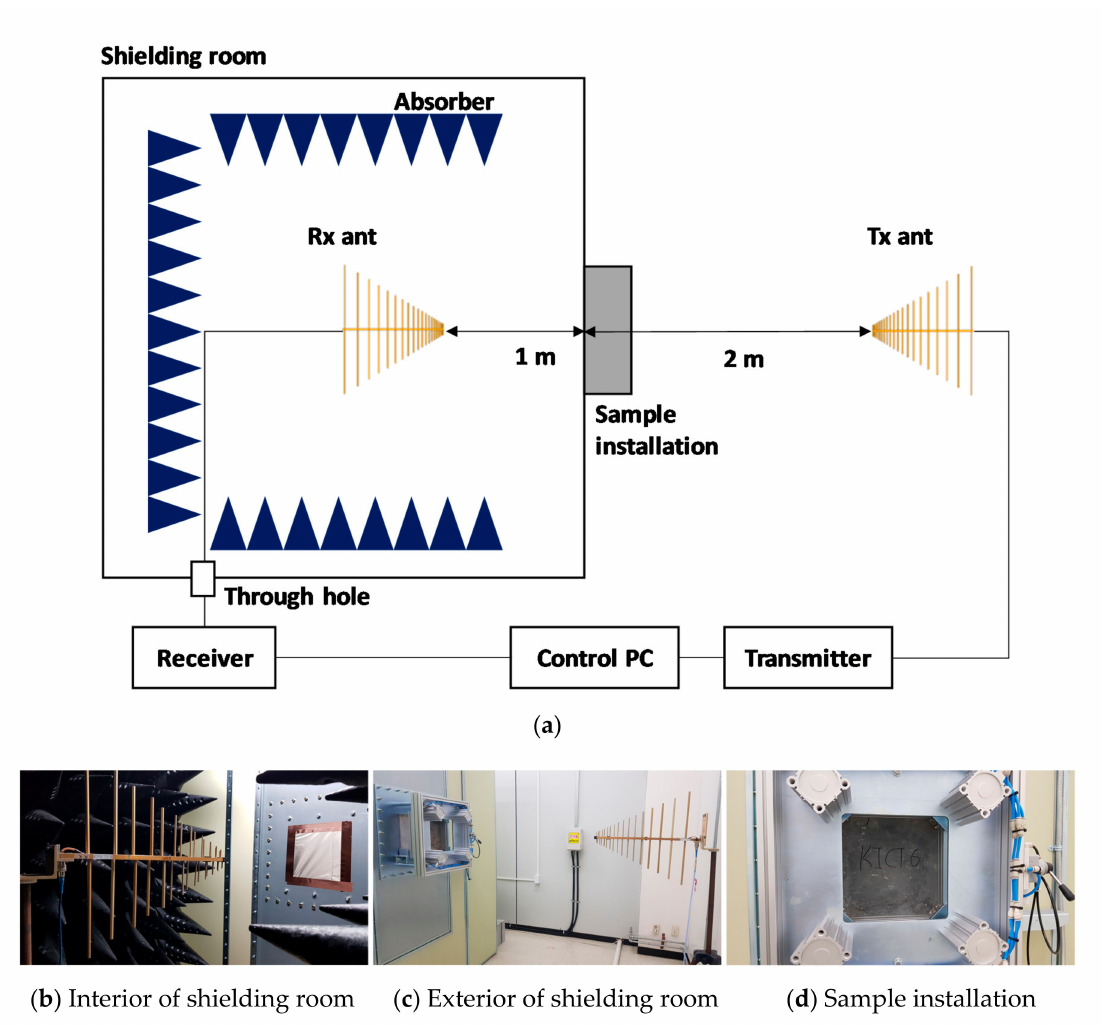
Figure 1. Schematic of the shielding e ff ectiveness (SE) measurement system. ( a ) System configuration, ( b ) Receiving (Rx) antenna placed inside the shielding room, ( c ) Transmitting (Tx) antenna placed outside the shielding room, and ( d ) Sample